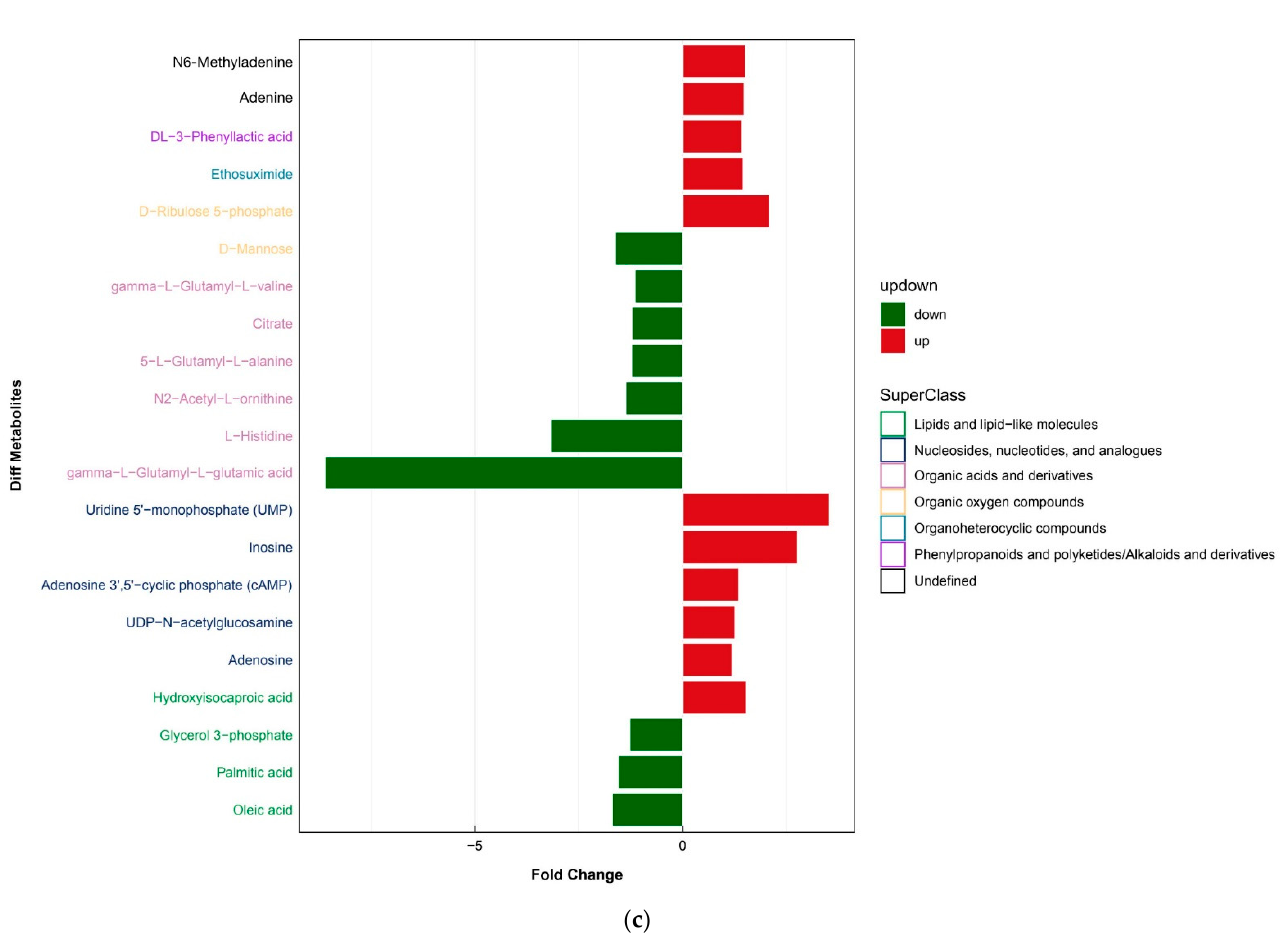
Figure 4. Metabolic diversity of the two K. pneumoniae strains. ( a ) Superclass pie chart of compounds secreted by the two K. pneumoniae strains. Numbers in parentheses indicate the total number of K. pneumoniae -associated volatile compounds for which the compound class could be determined per medium. ( b ) Analysis of significant differences in metabolite expression in positive-ion mode. ( c ) Analysis of significant differences in metabolite expression in negative-ion mode.